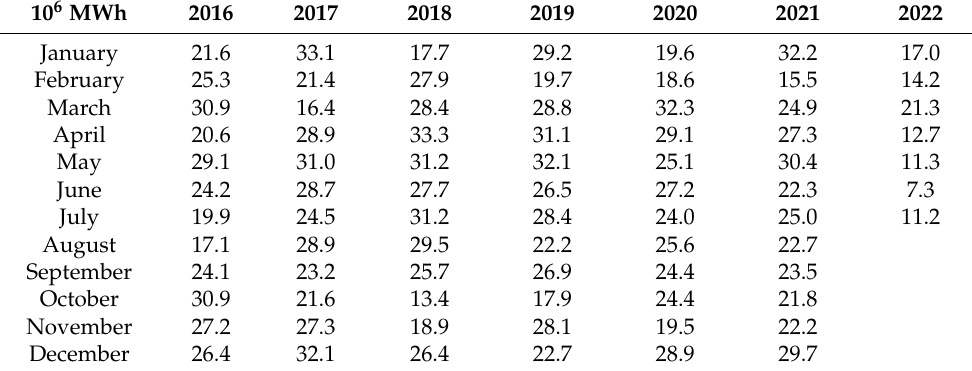
Table 8. Italy/Austria. Entry